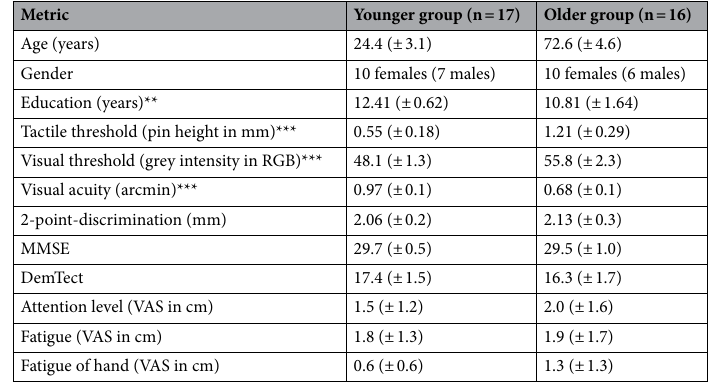
Table 1. Assessment data of the groups. Mean values are shown ± standard deviation. Based on significant main effects, post-hoc tests were conducted. Asterisks indicate significant differences between younger and older participants (**p < 0.01, ***p <